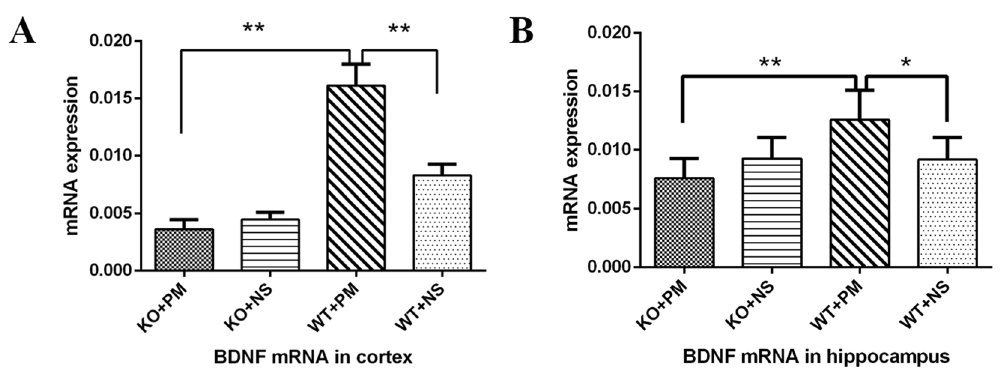
Figure 5. BDNF mRNA expression in the cortex and hippocampus at 24 h after inoculation with S. pneumoniae . BDNF mRNA expression in ( A ) the cortex and ( B ) hippocampus was significantly higher in infected wild-type mice than in control wild-type mice and infected myd88 − / − mice. However, BDNF mRNA expression was similar between infected myd88 − / − mice and control mice. * p < 0.05, ** p < 0.01. BDNF: brain-derived neurotrophic factor, KO: knockout, PM: pneumoniae meningitis, WT: wild-type, NS: normal